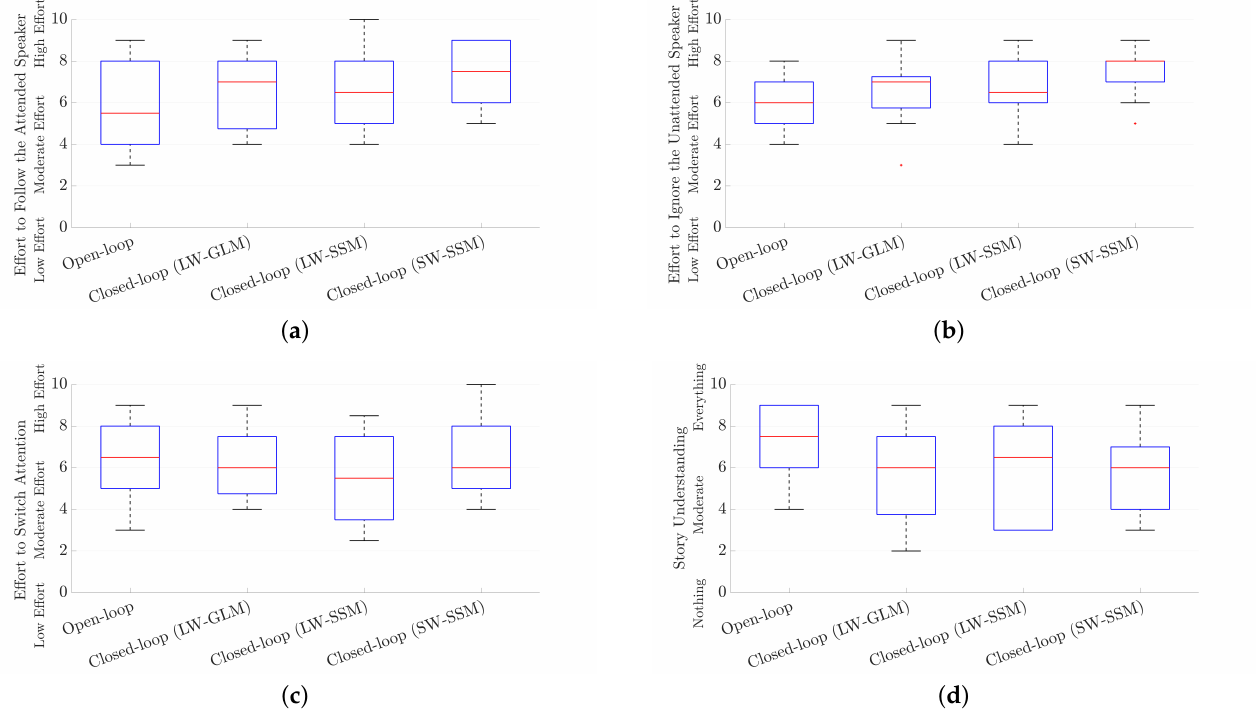
Figure 9. Subjective evaluation results of the open-loop and the closed-loop AAD phase using the LW–GLM, LW–SSM, and SW–SSM algorithms in terms of perceived effort to ( a ) follow the attended speaker, ( b ) ignore the unattended speaker, ( c ) switch attention between both speakers, and ( d ) understand the story.